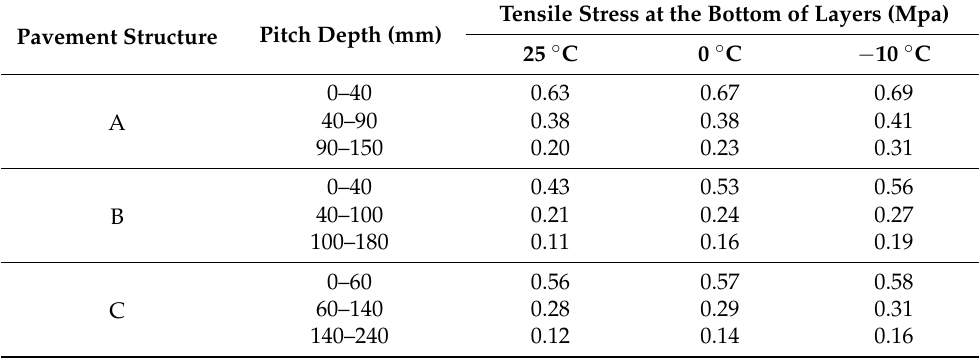
Table 5. Tensile stress at the bottom of each structure layer of asphalt pavement with a flexible base. Pavement Structure